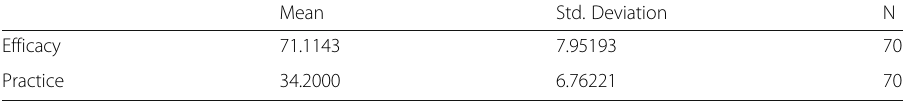
Table 1 Descriptive Statistics for Self-efficacy and Instructional Practice